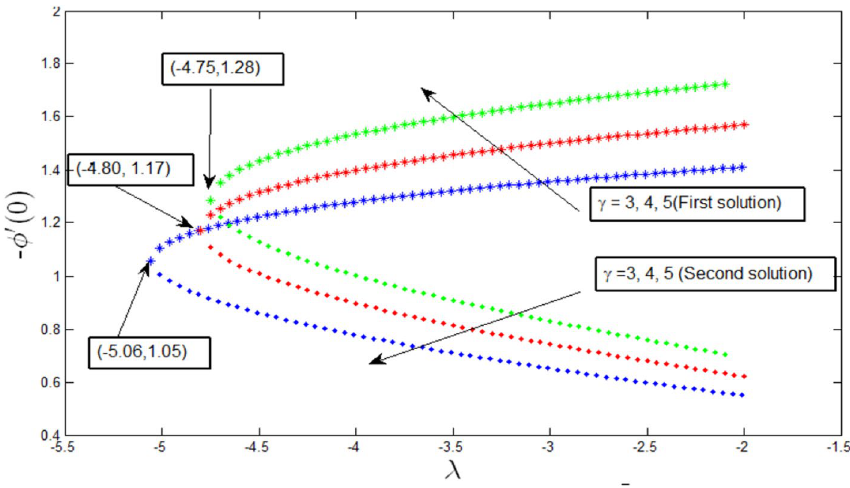
Figure 8. Variation of Sherwood number with (cid:31) for various γ when Lb = 1, Le = 0.5, Pb = 1, Nr = 0.5, Rb = 0.6, A = 0.2.